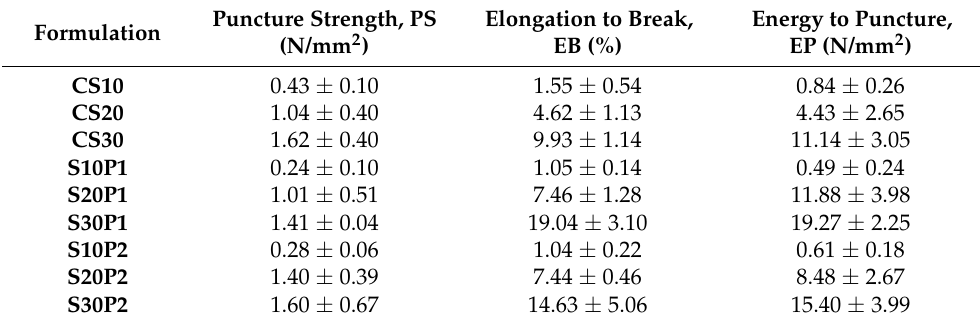
Table 3. Puncture strength, elongation to break and energy to puncture of all rice starch films (n = 3, mean ± SD). Puncture Strength, Formulation